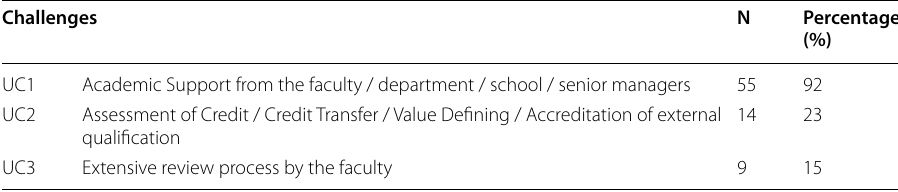
Table 6 Summary view of the challenges in implementing micro-credentials in higher educational institutions